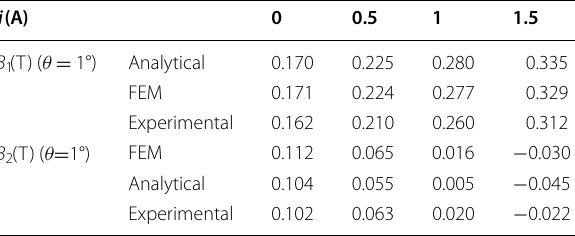
Table 5 Comparison of magnetic flux densities under different currents and rotation angles